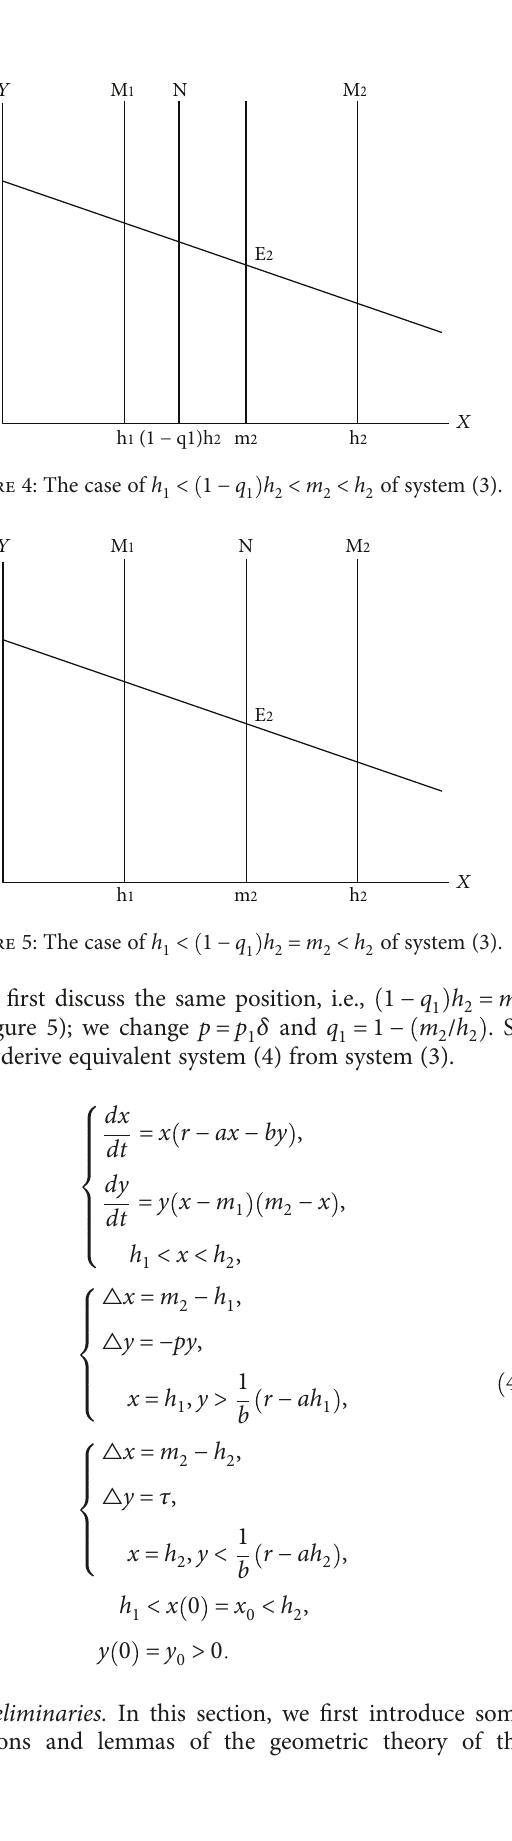
< m < h 2 2 of system 1 h 2